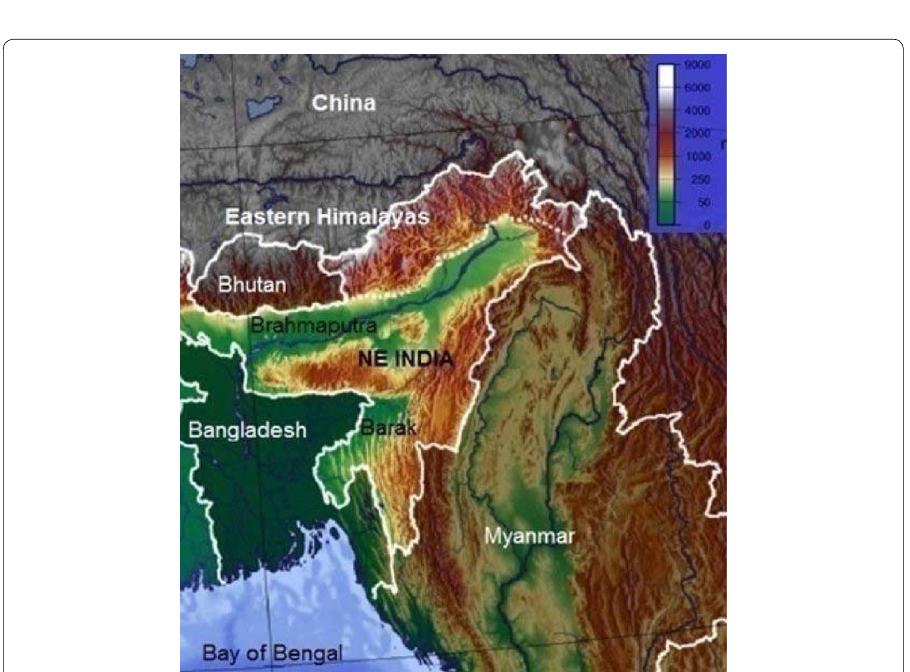
Fig. 2 Topography map of the northeastern region of